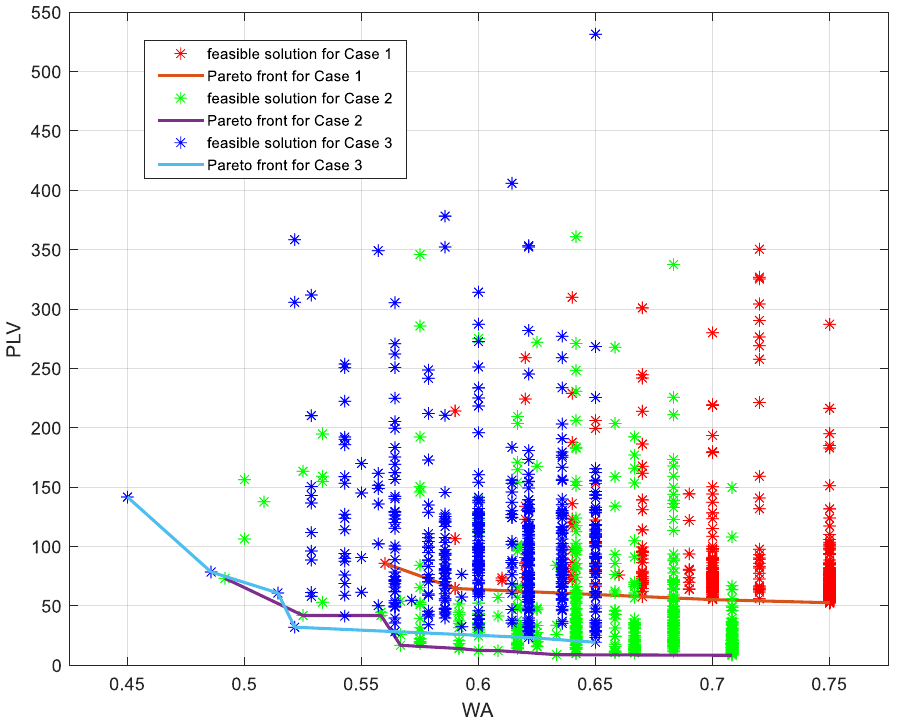
Figure 13. Pareto front and feasible solution for ITLBO-S.